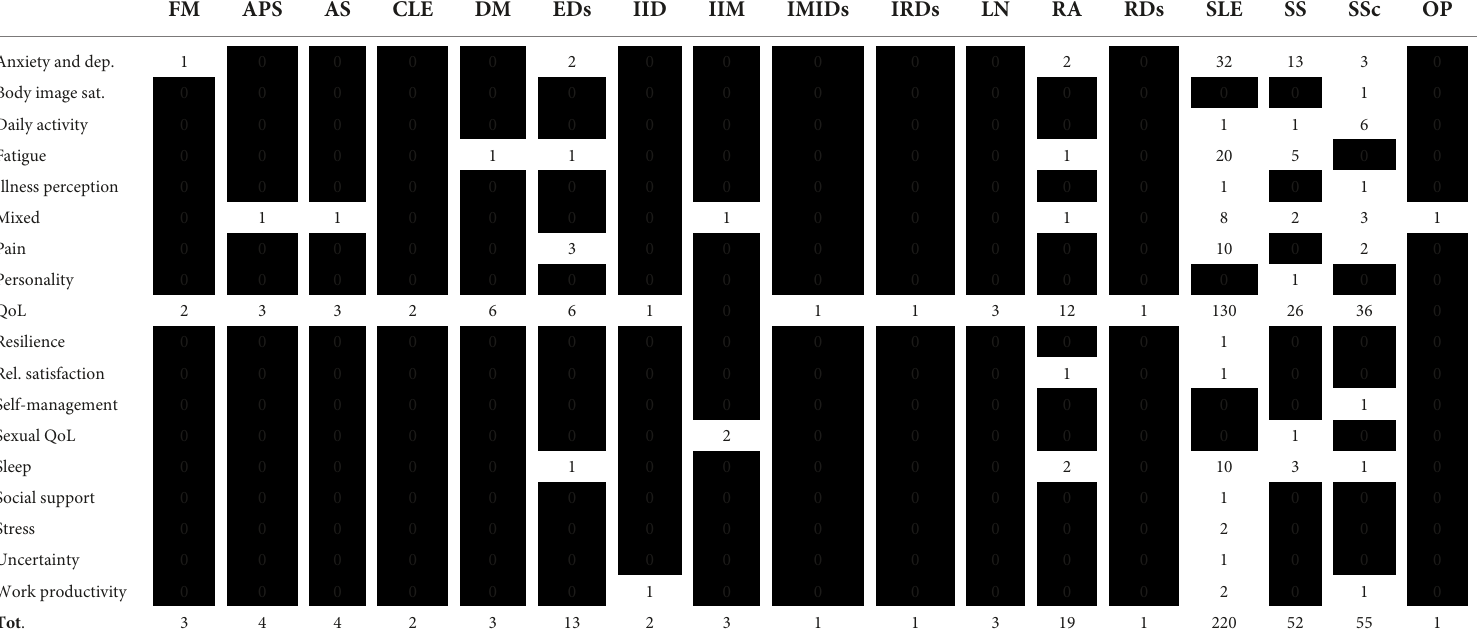
Anxiety and dep. Body image sat. Daily activity Fatigue